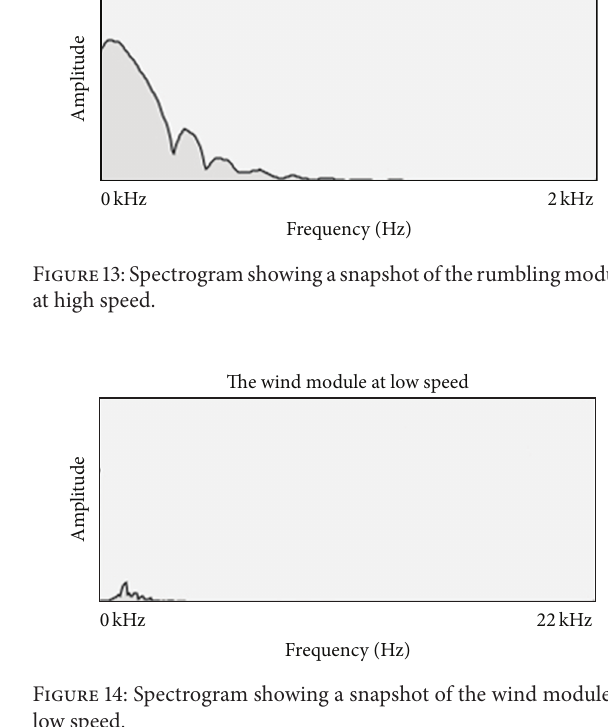
Figure12:Spectrogramshowingasnapshotoftherumblingmodule at low speed.